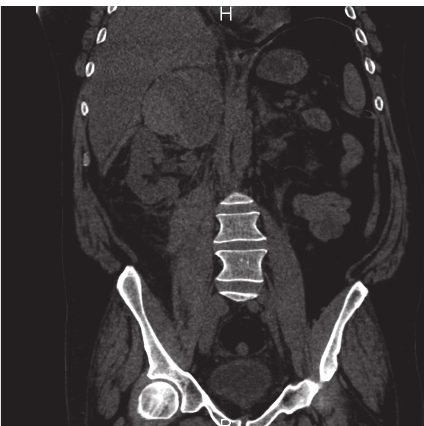
Figure 1: CT scan showing massive right adrenal hemorrhage.